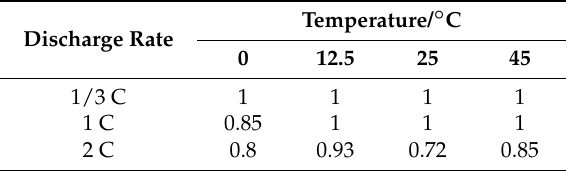
Table 3. MAE with or without correction under 2 C discharge.